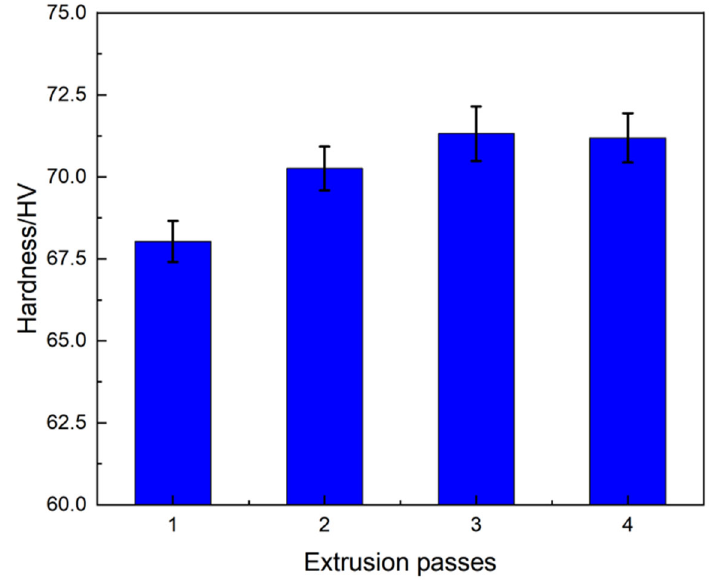
Figure 12. Hardness of 10 vol.% (AlFeNiCrCoTi0.5)p/6061Al composites with different extrusion passes.